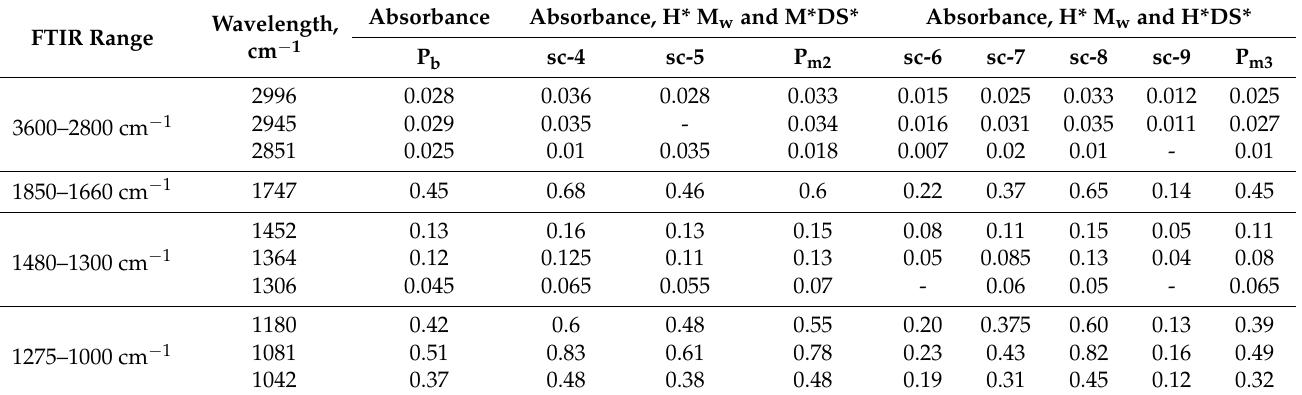
Table 3. The absorbance of the compounds resulting from stereo-complexing of base-PLLA with PDLA with a high M w (sc-4, sc-5, Pb, Pm2), and a high Mw and high DS (sc-6, sc-7, sc-8, sc-9, Pb, Pm3) (Mw and DS according to Table 1 and blends compositions as in Table